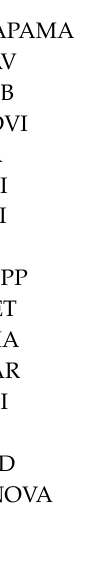
Table S1: E ff ect of growing conditions across phenological stages for the RGB indexes assessed from the ground level, Table S2: E ff ect of growing conditions across phenological stages for the RGB indexes assessed aerially, Table S3: E ff ect of growing conditions across phenological stages for the multispectral indexes assessed aerially, Table S4: E ff ect of the growing conditions across phenological stages for the thermal measurements, Table S5: E ff ect of growing conditions across phenological stages for the Dualex measurements, Table S6: Correlation coe ffi cients of the relationships between the pigment measurements with the Dualex and the